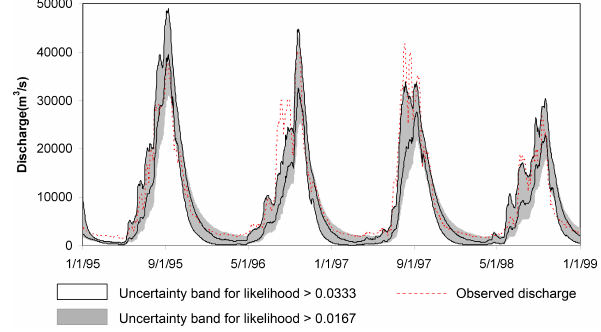
Fig. 7. Uncertainty bands for river discharge simulations made from parameter sets with associated likelihood values higher than 0.0167 and